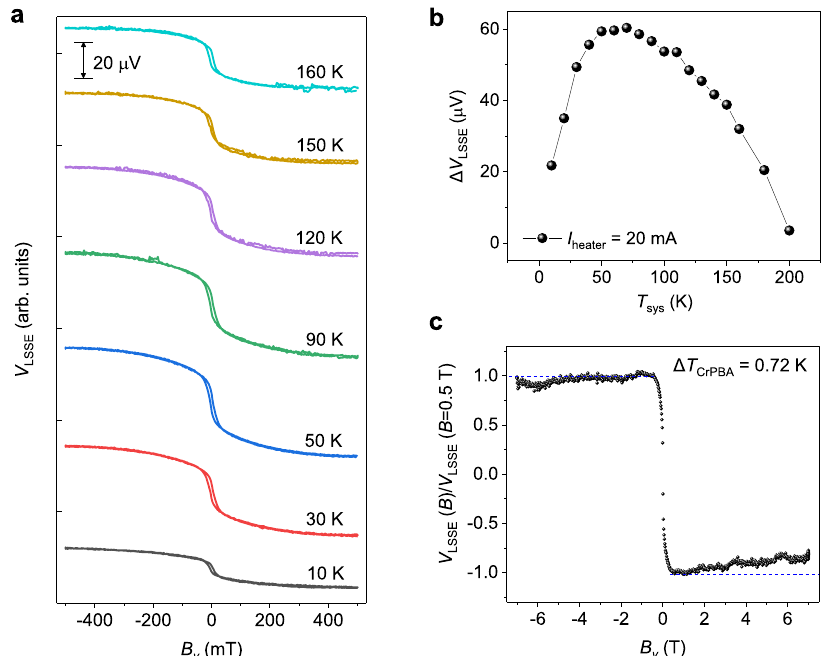
Fig. 3 Temperature- and fi eld dependence of V LSSE . a Temperature dependence of V LSSE measured with a Joule heating current, I heater = 20 mA ( Δ T Cr-PBA = 0.72 K). Measurements were done for the Cr-PBA (1.4 μ m)/Cr (10 nm) STE device with a sweeping magnetic fi eld ( B y ) between – 0.5 and 0.5 T. V LSSE ( B y ) curves are vertically shifted for clarity. b Temperature dependence of Δ V LSSE = j V LSSE ðþ B y Þ − V LSSE ð(cid:2) B y Þj ( B y = 0.5 T), displaying a peak at around 60 K. c High magnetic fi eld dependence of V LSSE measured at 100 K with I heater = 20 mA ( Δ T Cr-PBA = 0.72